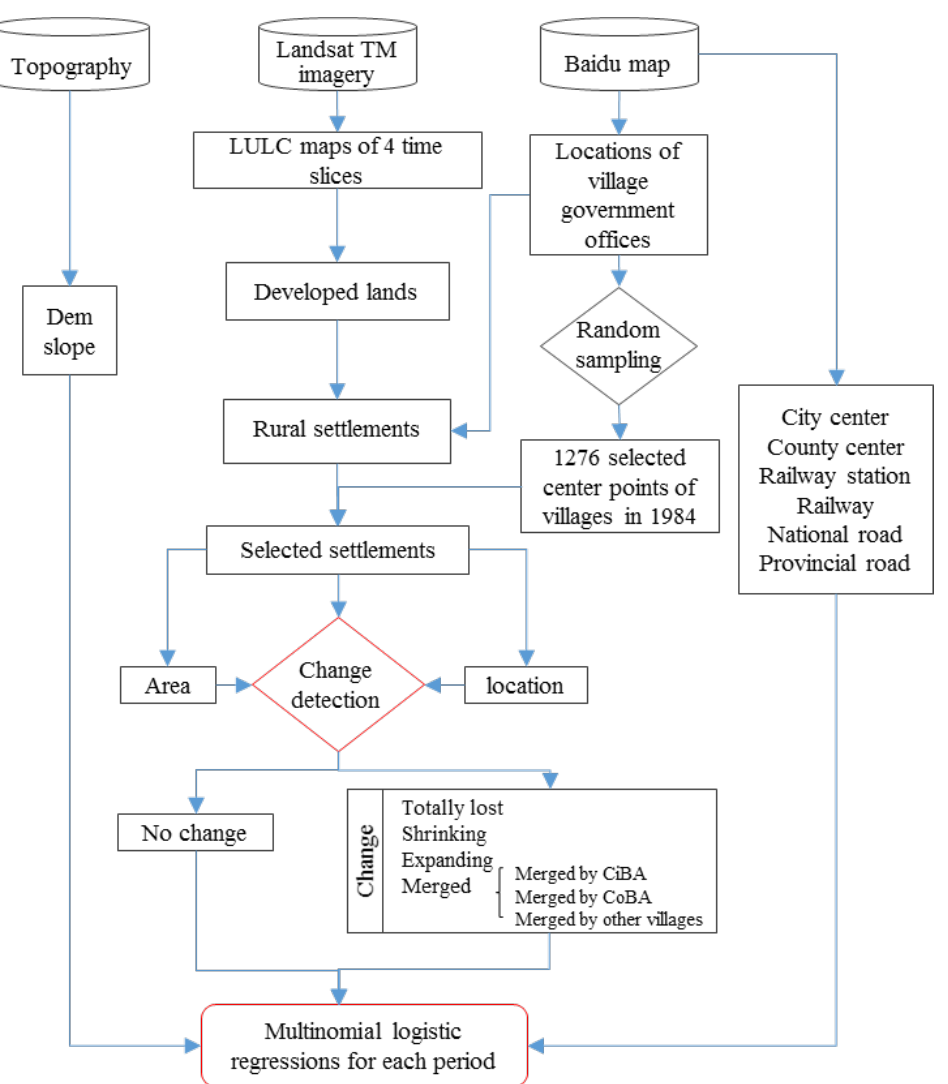
Figure 2. Flow chart of change detection and driving analysis of rural settlements.